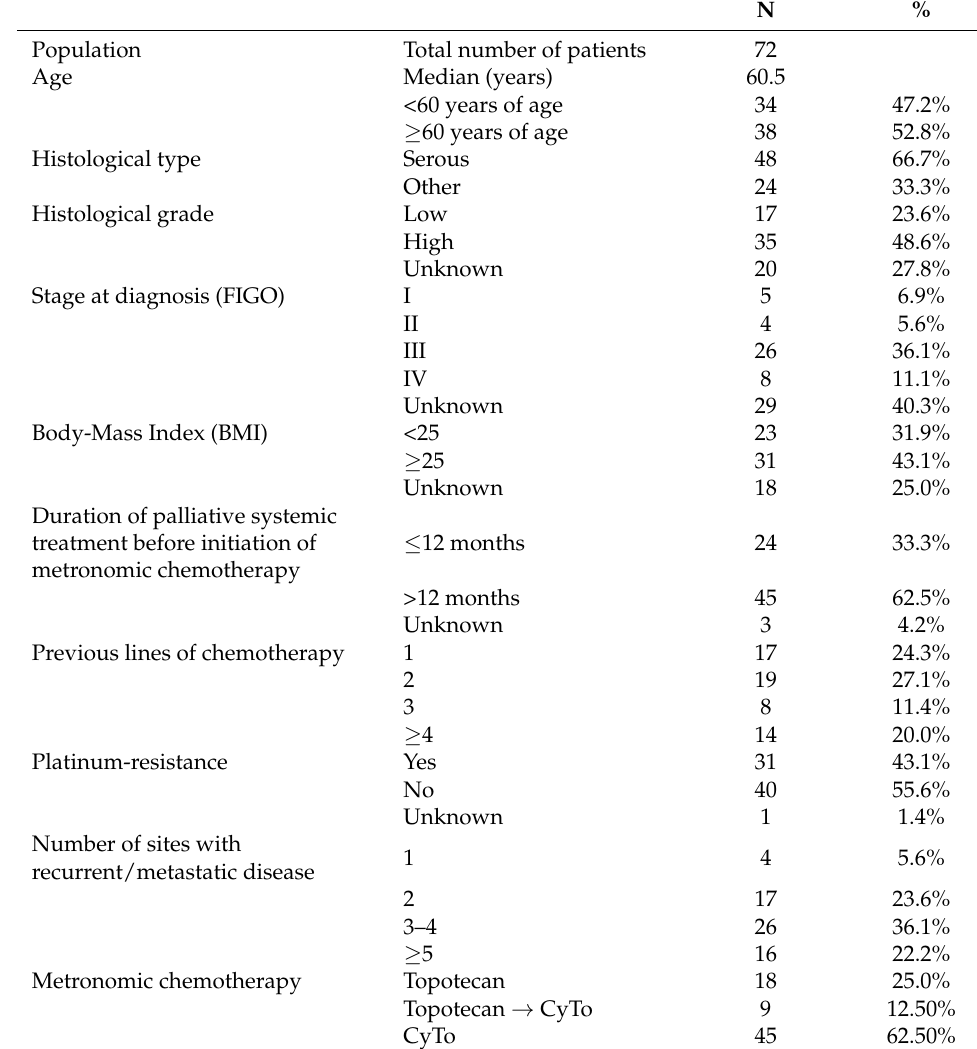
Table 1. Clinicopathological characteristics of